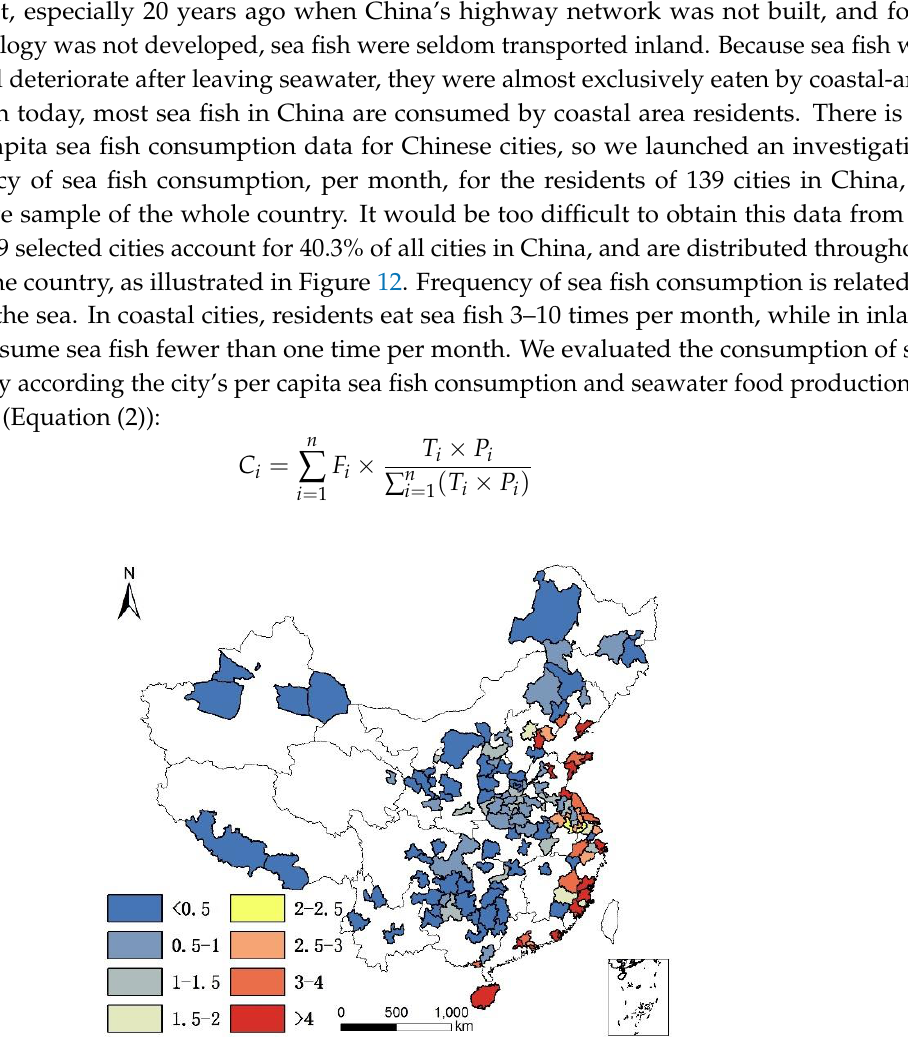
Figure 12. Sea fish diet frequency per month of residents in 139 cities of China (kg).